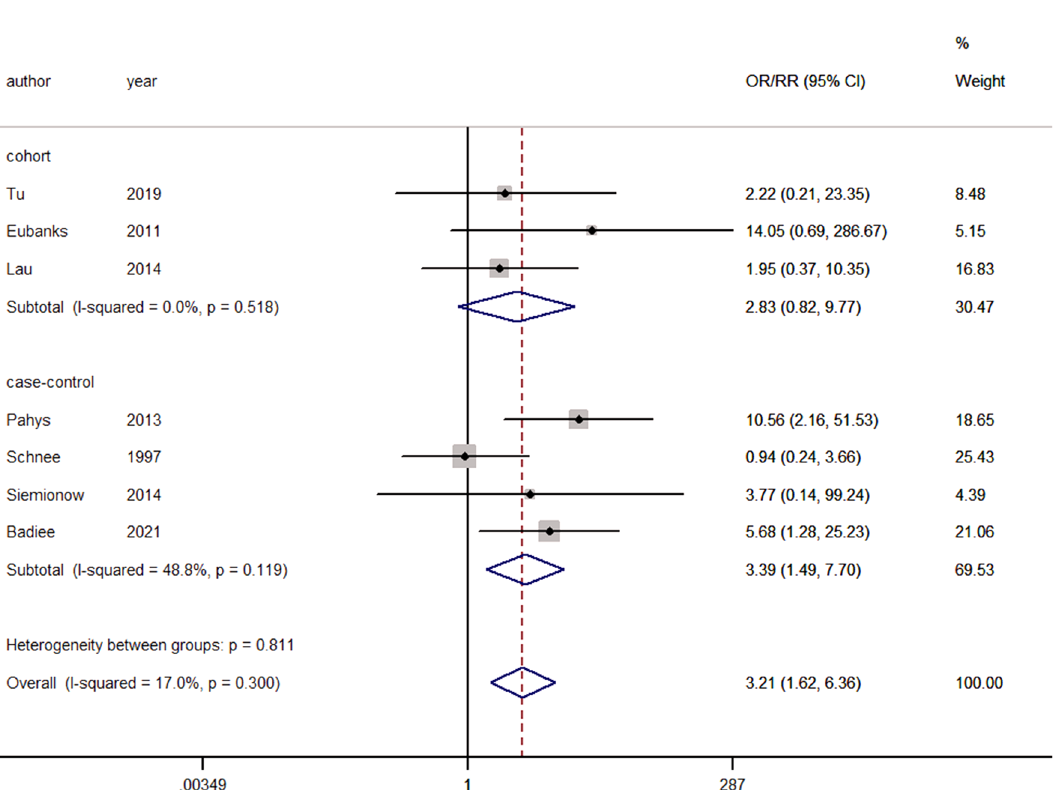
Figure 7. Forest plot showing the effect of smoking on wound infection. OR, odd rate; RR, risk rate; CI, confidence